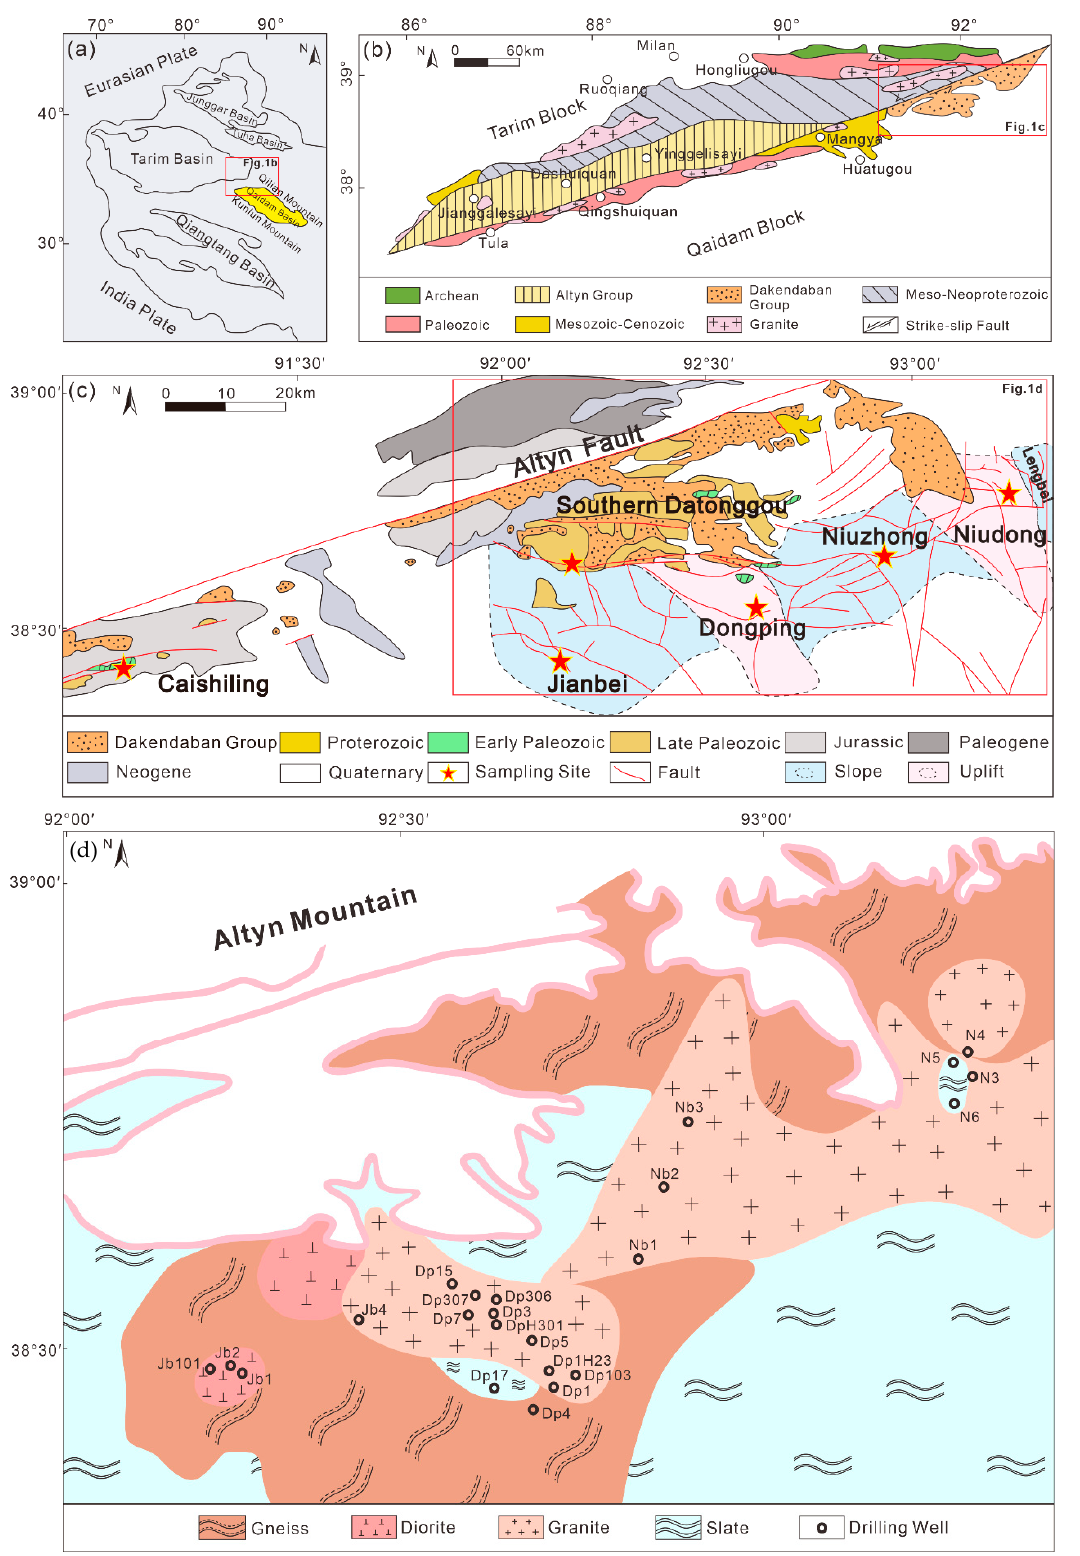
Figure 1. ( a ) Geological sketch map of the Qaidam region. ( b ) Tectonic sketch map of the Altyn orogenic belt (modified after Wu et al. [57] and Niu et al. [58]). ( c ) Sampled areas analyzed in this study (modified after Niu et al. [58]). ( d ) Lithological distribution and the drilling well locations of Qinghai oilfield in Qaidam Basin.